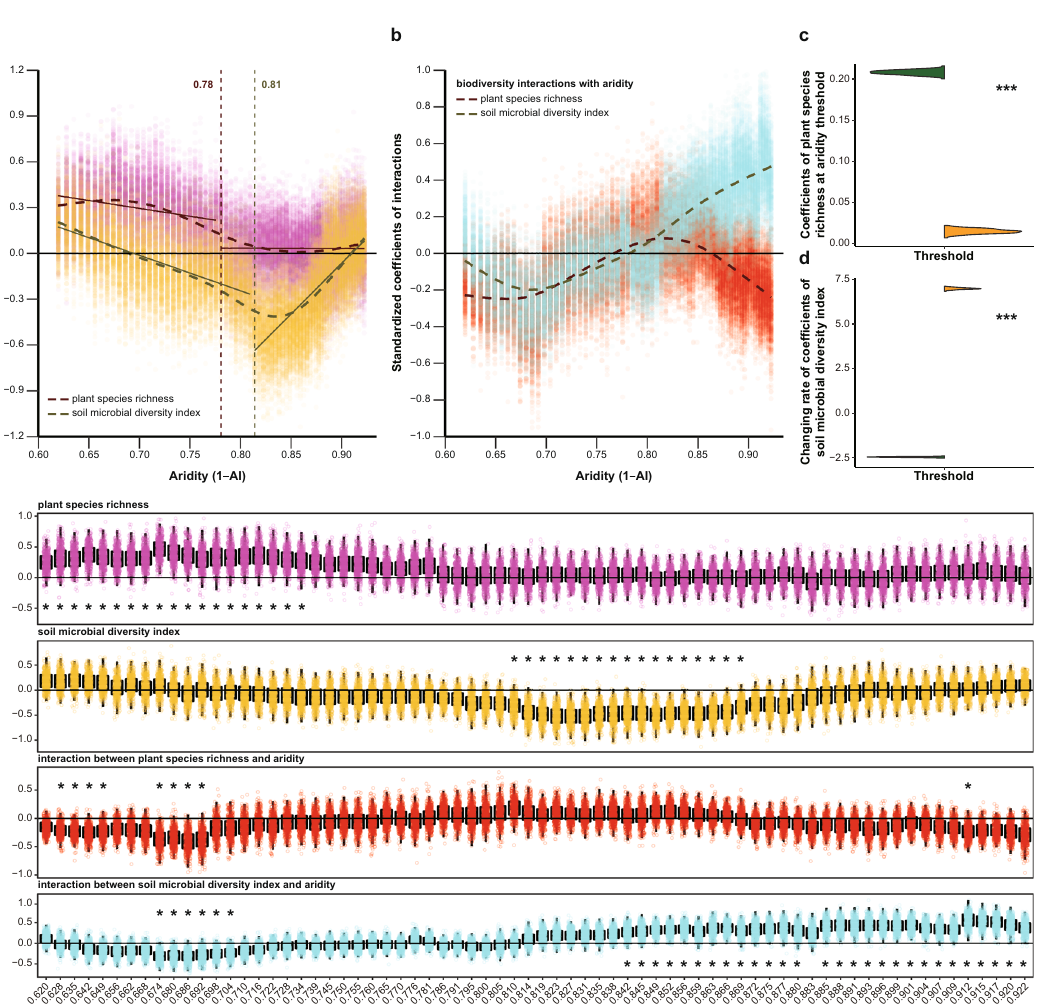
Fig. 3 Nonlinear changes of relationships between biodiversity and its interactions with aridity and soil multifunctionality along aridity gradients. a , b Nonlinear changes of standardized coef fi cients of biodiversity ( a ) and the interactions between biodiversity and aridity ( b ) obtained from a linear mixed- effects model (Eq. 3) throughout a moving subset window of the fi eld sites surveyed along aridity gradients. The dots indicate the bootstrapped coef fi cients of the fi xed terms shown for each subset window. The dashed lines denote the nonlinear trend fi tted by GAMs. In ( a ), the vertical dashed lines and inset numbers represent the aridity thresholds identi fi ed, and the solid lines represent the linear fi ts at both sides of each aridity threshold. c , d Violin diagrams show bootstrapped predicted values at the threshold ( c ) and bootstrapped slopes ( d ) of the two regressions existing at each side of the aridity threshold found for plant species richness and the soil microbial diversity index in ( a ), respectively (dark green for the regression before the threshold and orange for the regression after the threshold). Signi fi cant differences between before and after the threshold are determined using an unpaired two-sided Mann – Whitney U -test. Signi fi cance level is: *** P < 0.001. e Boxplots demonstrate the distribution of bootstrapped standardized coef fi cients corresponding to those in ( a , b ) for each subset window ( N = 500 independent simulations). Boxplots show the median (center line), 25th and 75th percentiles of each distribution. Whiskers represent the minimum and maximum values that remain inferior 1.5 times the interquartile range below or above the distribution median. Asterisks indicate signi fi cant values of coef fi cients at 95% con fi dence intervals (one-sided P ≤